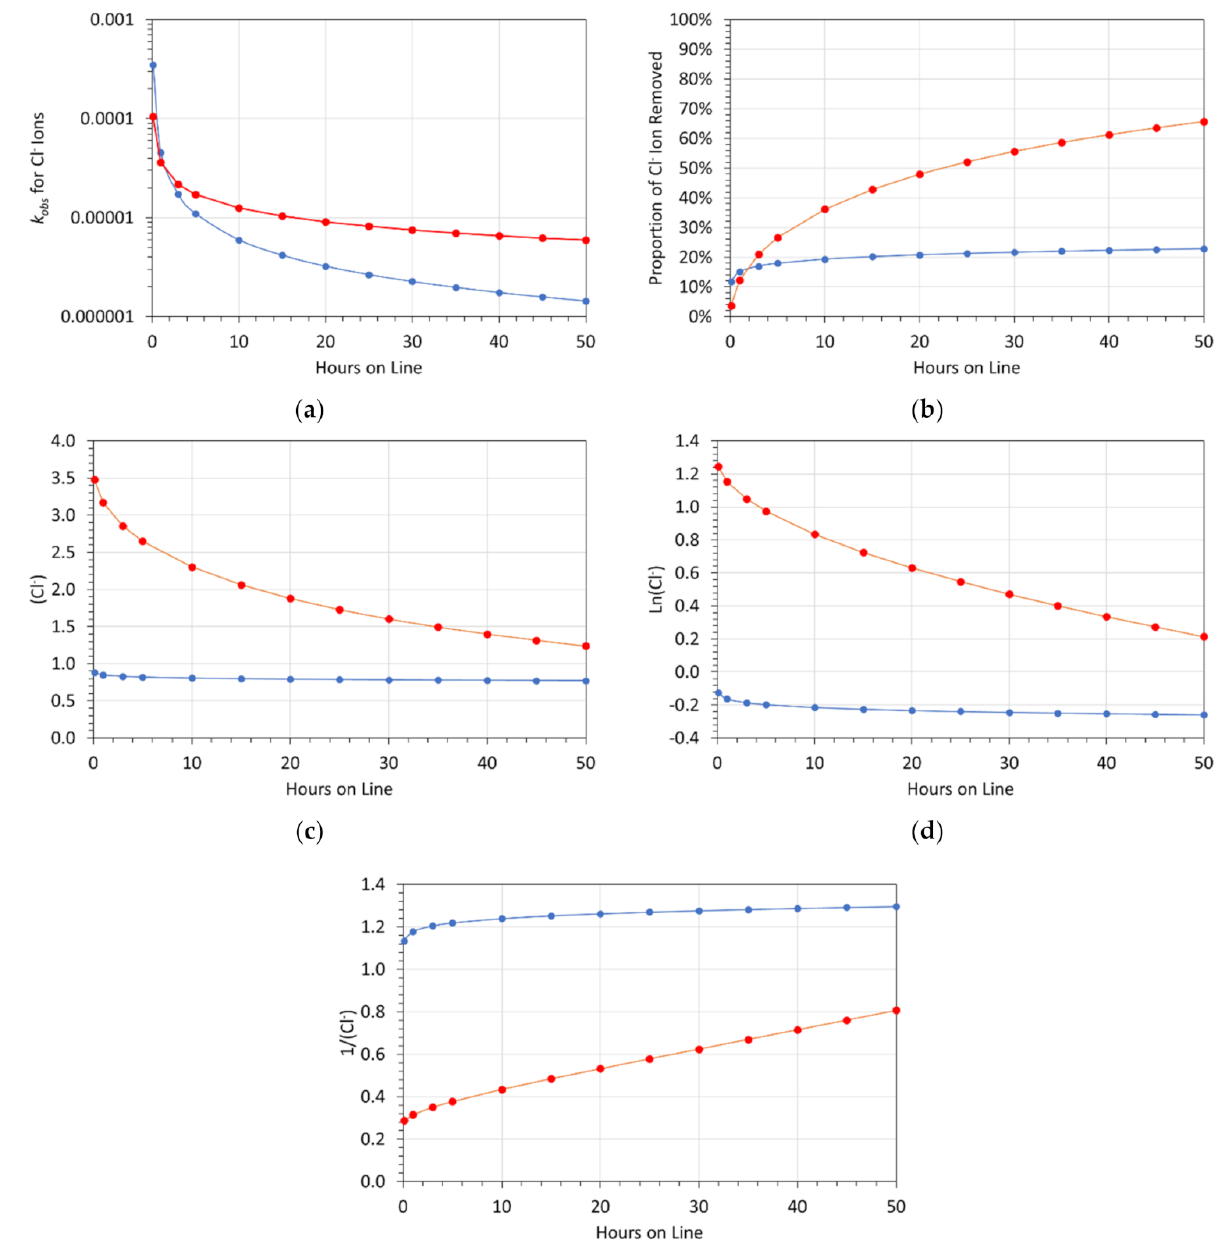
Figure 16. Example relationships. ( a ), k obs vs. hours on line; ( b ) proportion of ion removed vs. hours on line; ( c ) zero − order reaction check. Cl − ion concentration, g L − 1 vs. hours on line; ( d ) first- order reaction check. Ln(Cl − ) ion concentration, g L − 1 vs. hours on line; ( e ) second-order reaction check. 1/Cl − ion concentration, g L − 1 vs. hours on line; data source: Table A3. Red line: Trial 18. 3.61 g Cl − L − 1 ; blue line: Trial 4. 1.0 g Cl − L − i